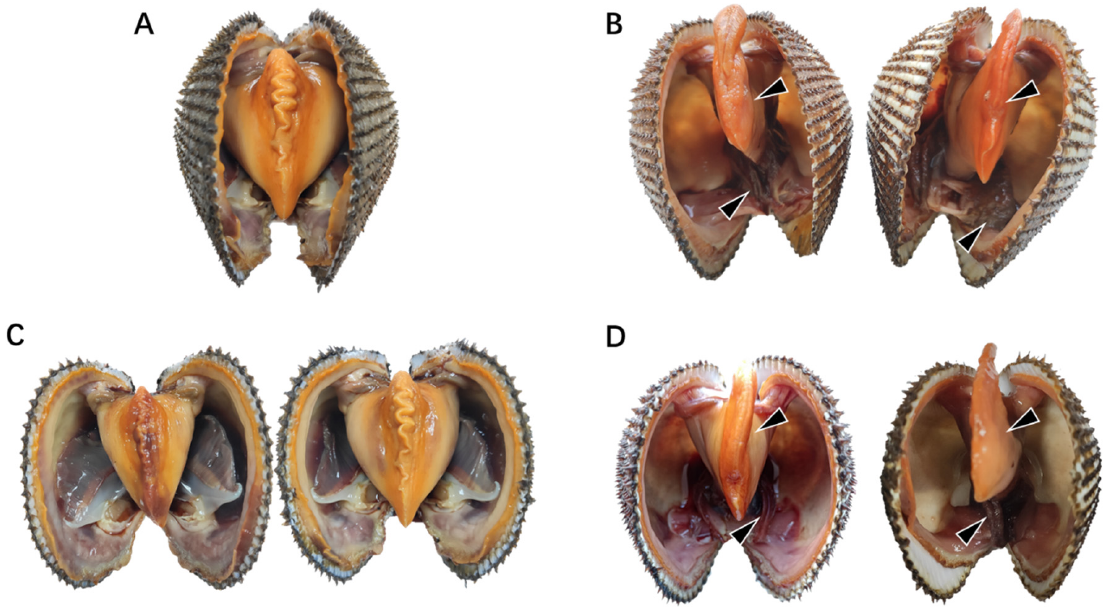
Figure 1. Symptoms of natural diseased ark clams. ( A ) Healthy ark clams. ( B ) Natural diseased ark clams. ( C ) Ark clams in the control group without SbA1-1 challenge at low (15 °C, left ) and high (25 °C, right ) temperatures. ( D ) Ark clams challenged with SbA1-1 strain (1 × 10 5 CFU/mL) under 15 °C ( left ) and 25 °C ( right ). The black arrow marks the site of the lesion.